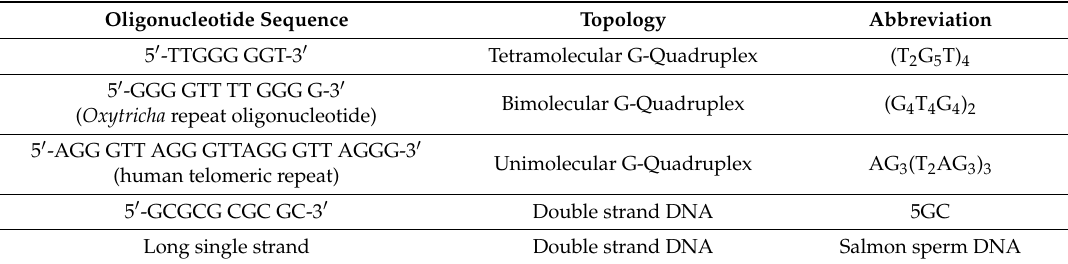
Figure 2. Structures of the studied TMPyP and thiopyridinium (ZnPc1, ZnPc2) and methoxypyridinium (ZnPc3, ZnPc4) phthalocyanines. Table 1. Sequence and topology of studied oligonucleotides.